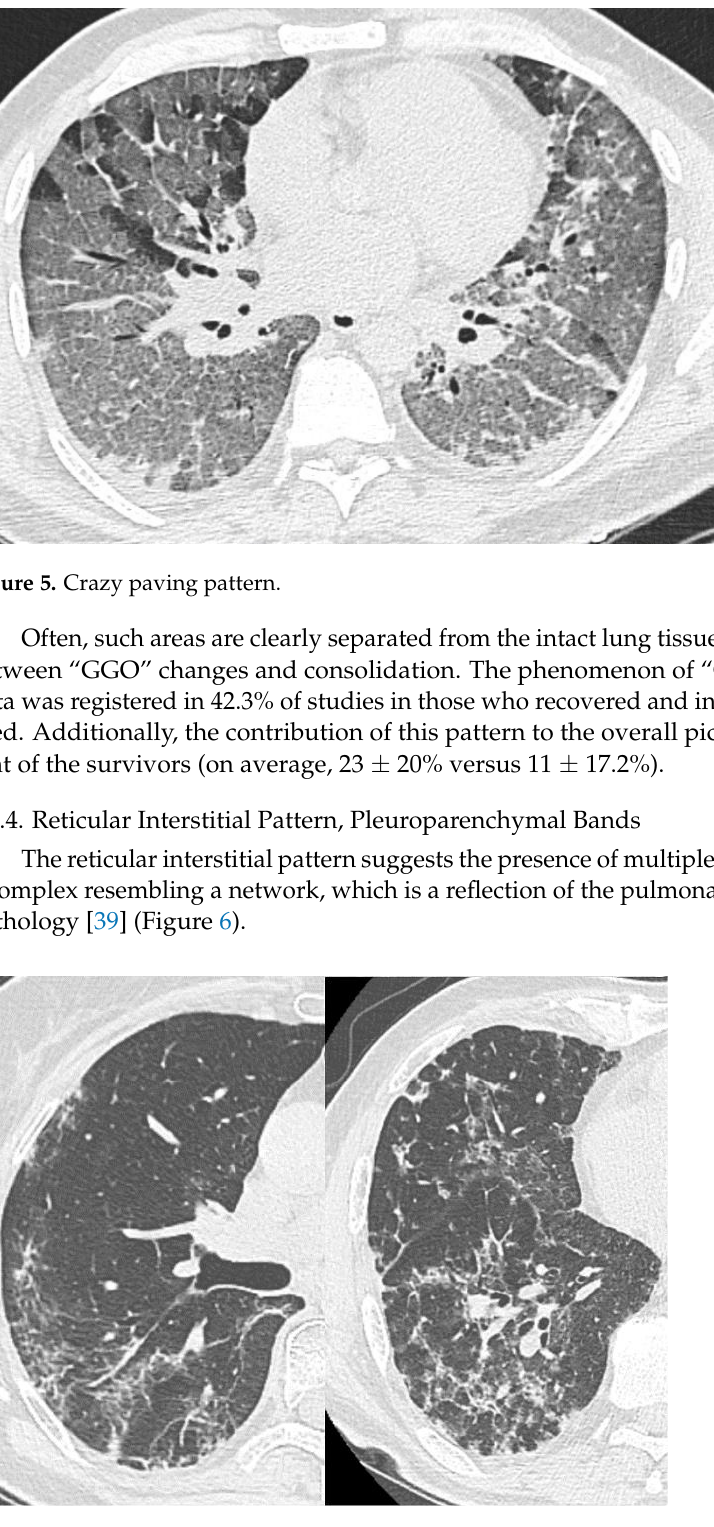
Figure 6. Reticular interstitial pattern.